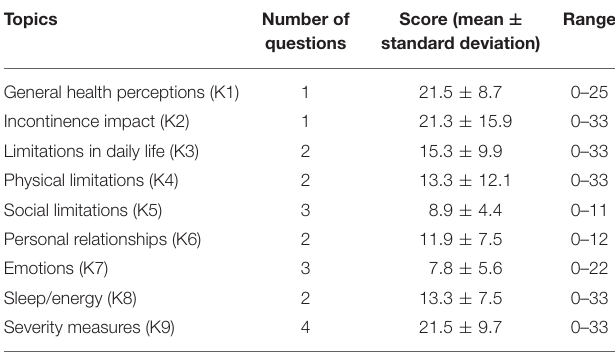
TABLE 5 | Evaluation of QoL by means of the KHQ questionnaire.